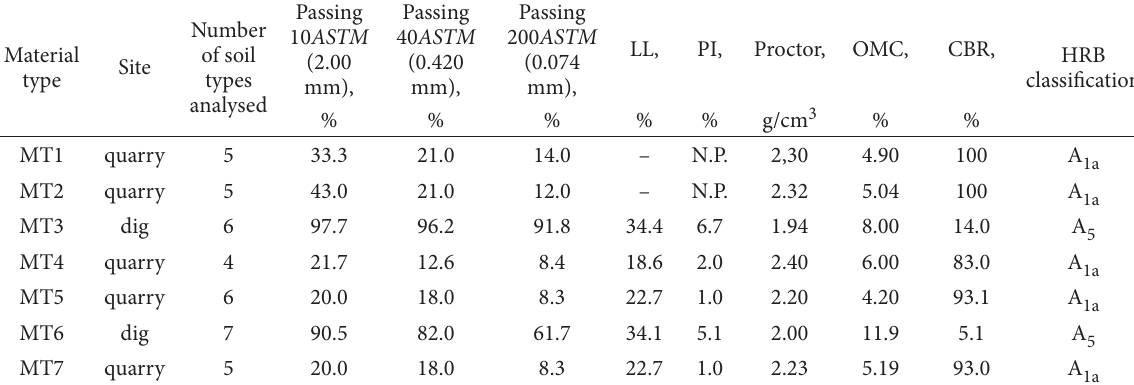
Table 1. Soil types analysed and results of standard ASTM laboratory